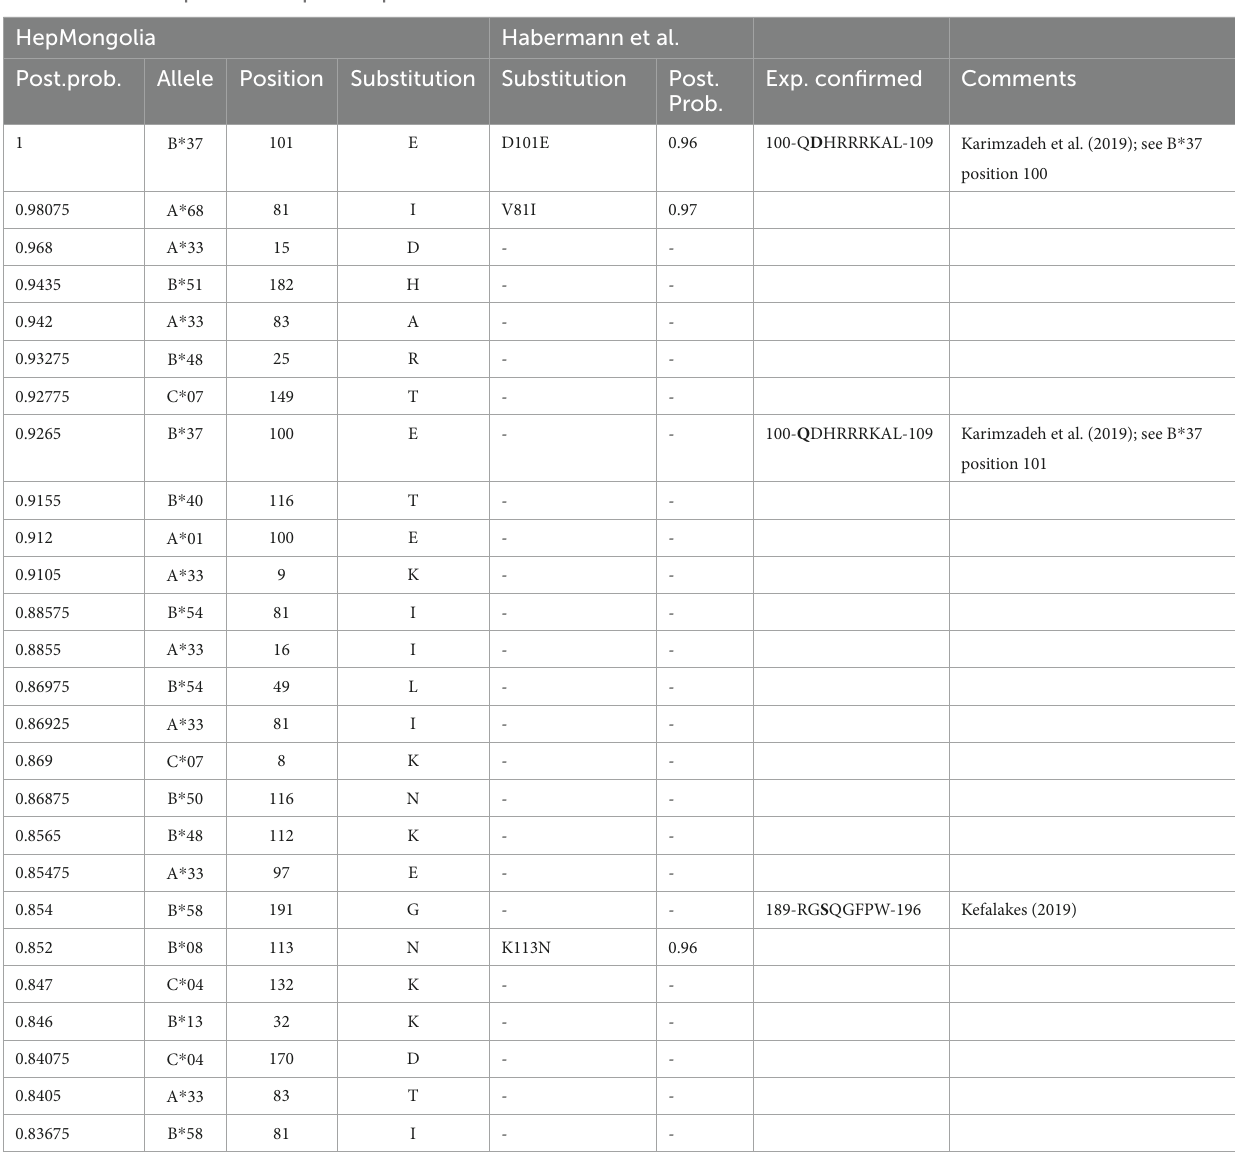
TABLE 3 List of HAMs predicated on posterior probabilities.